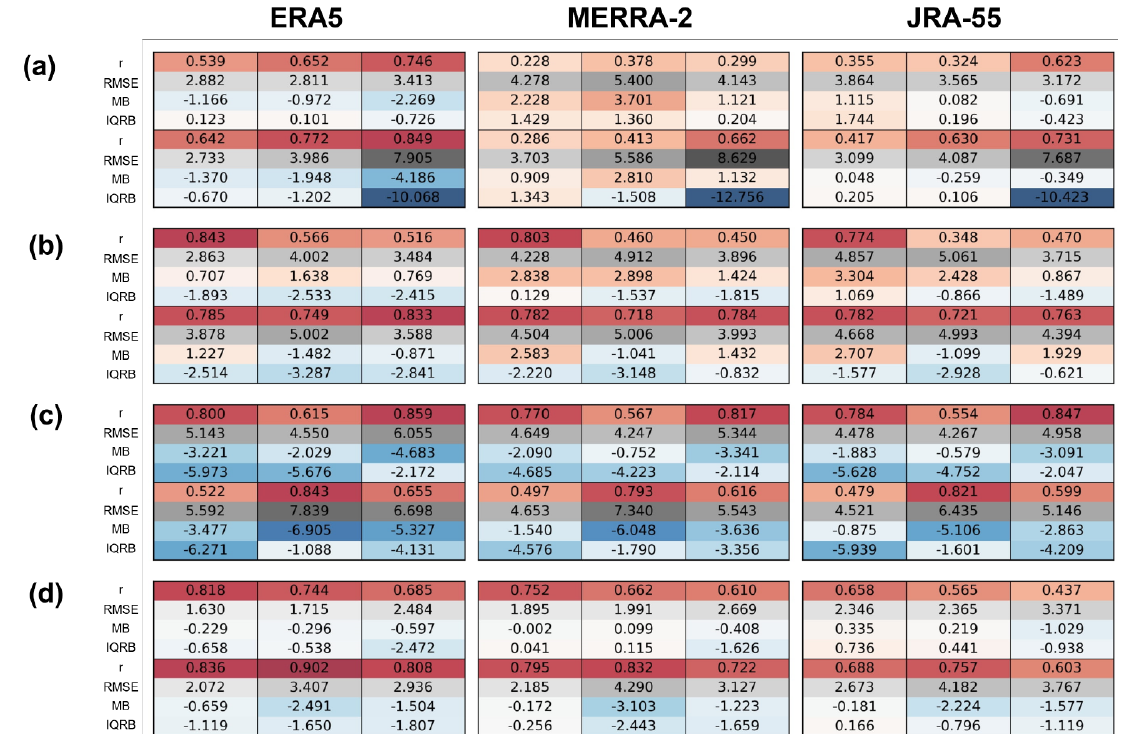
Table D1. Performance statistics calculated from reanalysis vs. observed 12-hourly 10m wind speed for (a) Casey, (b) DDU, (c) Mawson and (d) Neumayer. Left three columns correspond to ERA5, middle three MERRA-2 and right three JRA-55, with individual outlined boxes corresponding to SOM nodes as laid out in Fig. 5. Statistics shown include (by row) Pearson’s correlation coefficient ( r ), root mean